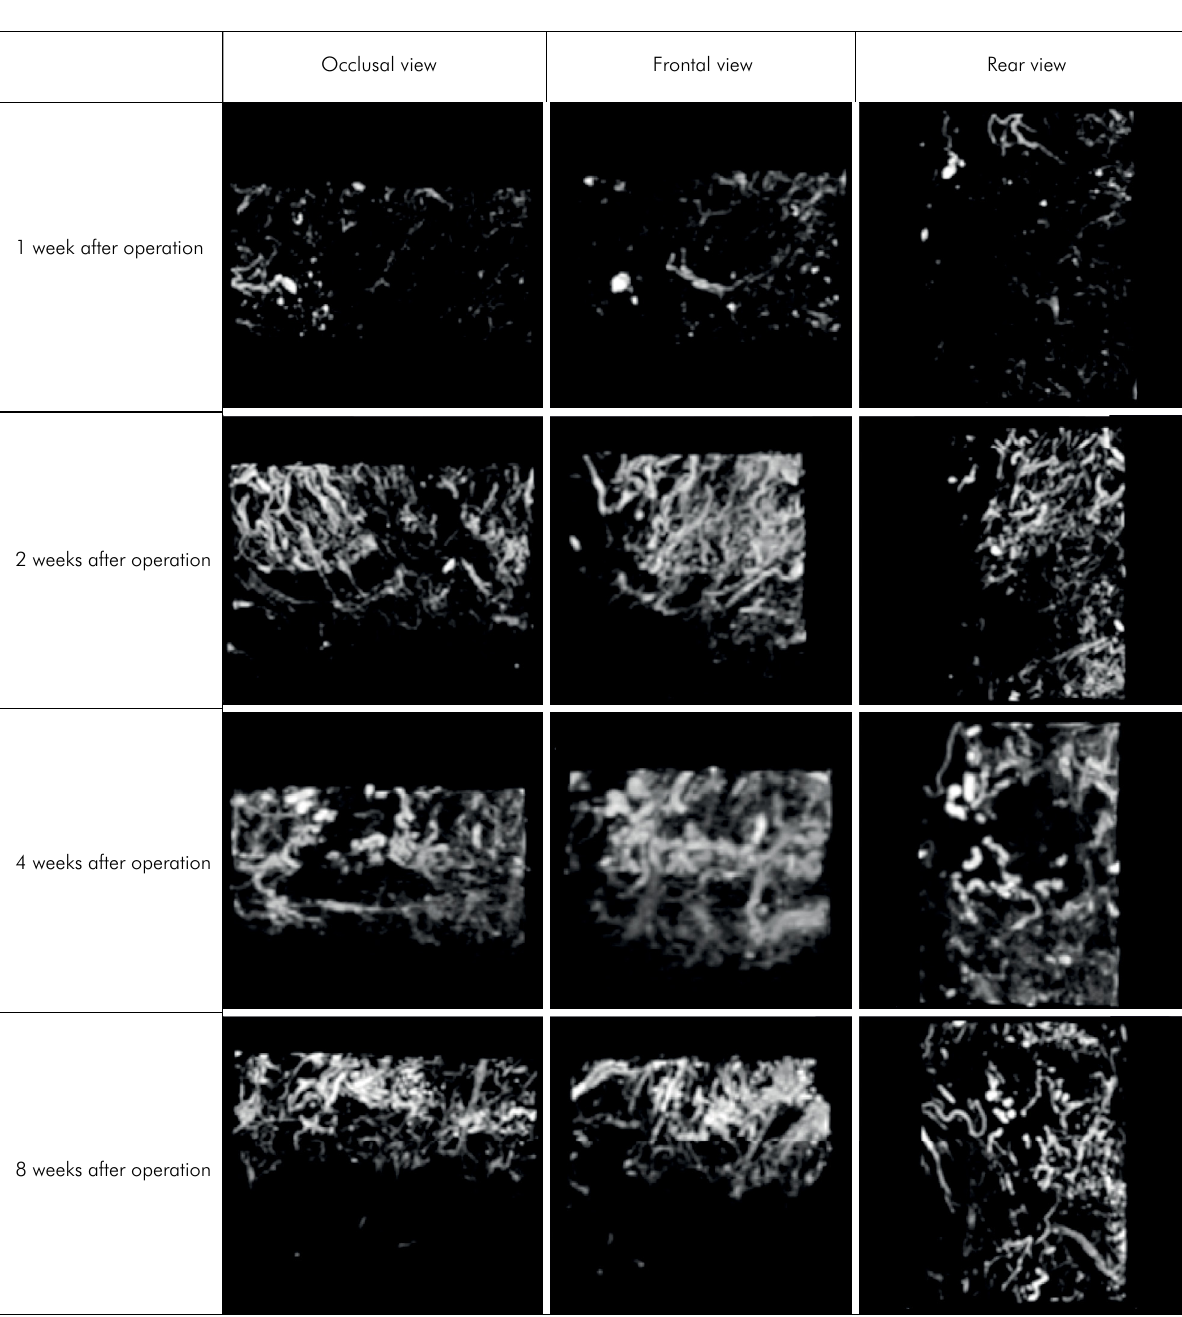
5 Braz. Oral Res.